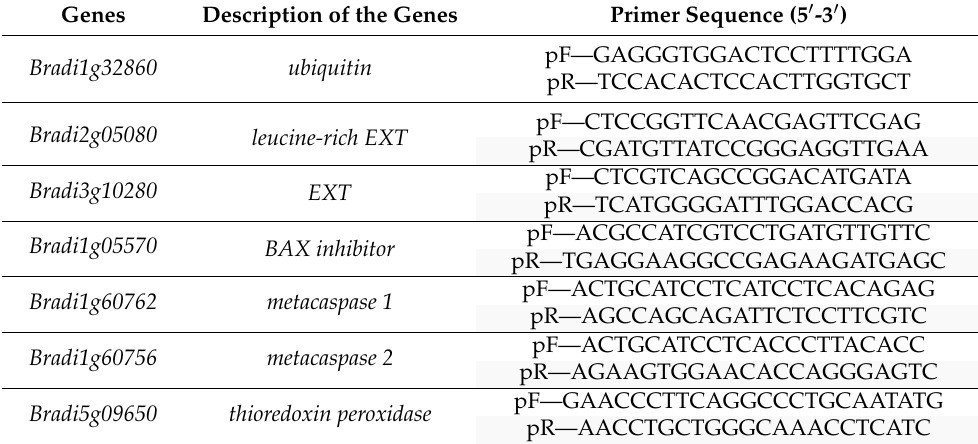
Table A1. The oligonucleotide primers that were used for the RT-qPCR reaction with relevant descriptions of the